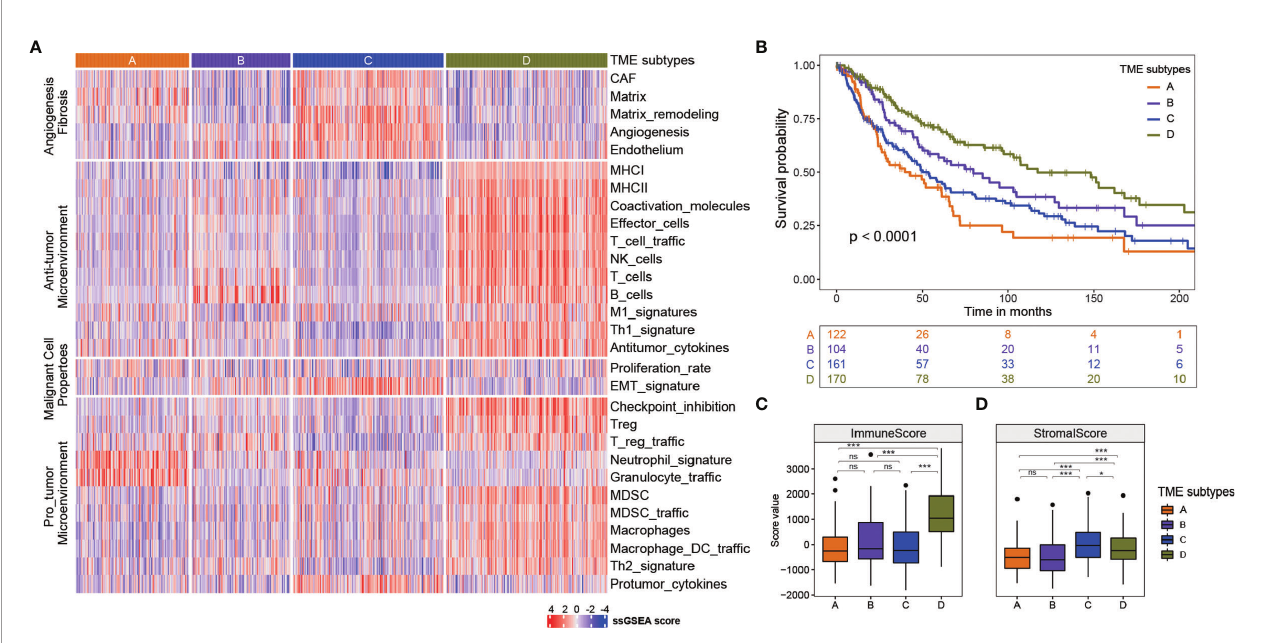
FIGURE 1 | Four TME subtypes identi fi ed in melanoma. (A) Four TME subtypes showed differences in expression patterns of these 29 Fges. (B) Kaplan-meier curves of overall survival for four TME sbutypes. Log rank test p <0.0001. The mouths were calculated by years*365/12 or days/365*12. (C) The immune score of four TME subtypes. *** p<0.001; ns, no signi fi cance. (D) The stromal score of four TME subtypes. * p<0.05; *** p<0.001; ns, no signi fi